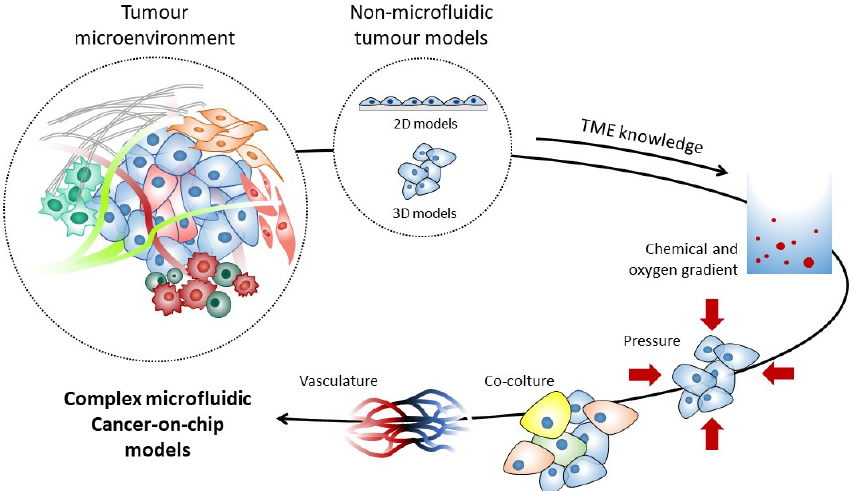
Figure 4. The microfluidic cancer-on-chip model. The setup of models suitable for the study of the complex interactions among different cell types and signalling molecules within the tumour mi- croenvironment is still a major challenge. Commonly used 2D in vitro models poorly represent in vivo tumoral niches, and thus many 3D models have been developed. Among these models, the microfluidic cancer-on-chip model has the unique advantage of recapitulating tumoral microenvi- ronment in a bioengineered microdevice able to summarize crucial functional aspects of the peri- tumoral niche, e.g., gas exchange, to maintain chemical and oxygen gradients, the preservation of biomechanical forces and pressure, the inclusion of multiple cell types and finally the presence of endothelial cells organized in an aligned structure resembling blood vessels.